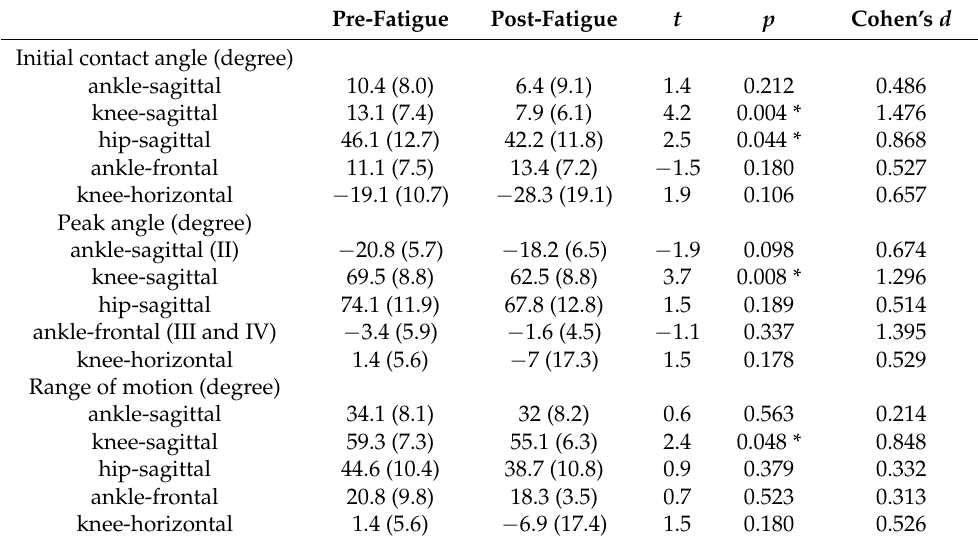
Table 2. Initial contact and peak angle, and range of motion (RoM) of ankle, knee and hip (mean ± SD). Pre-Fatigue